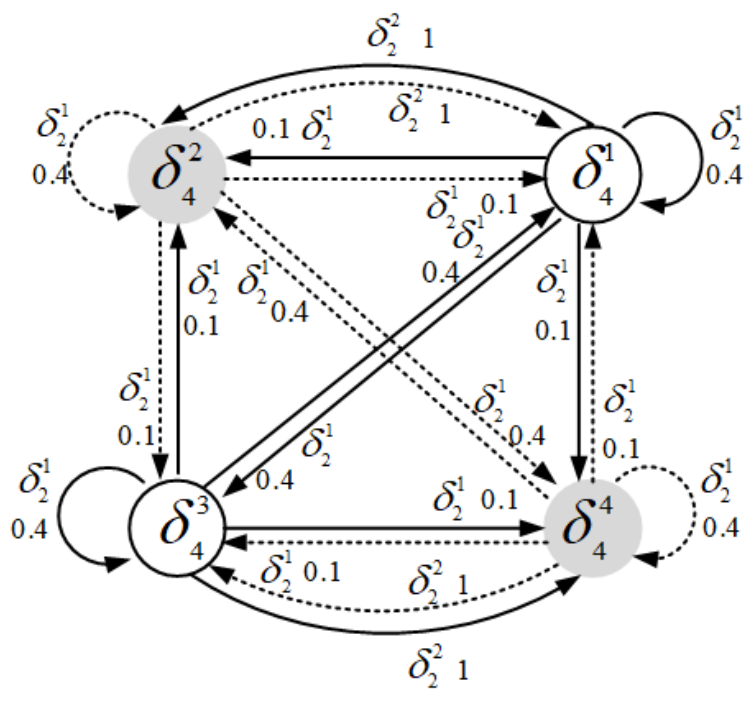
Figure 1. STG of the PBMCNs (4) in Example